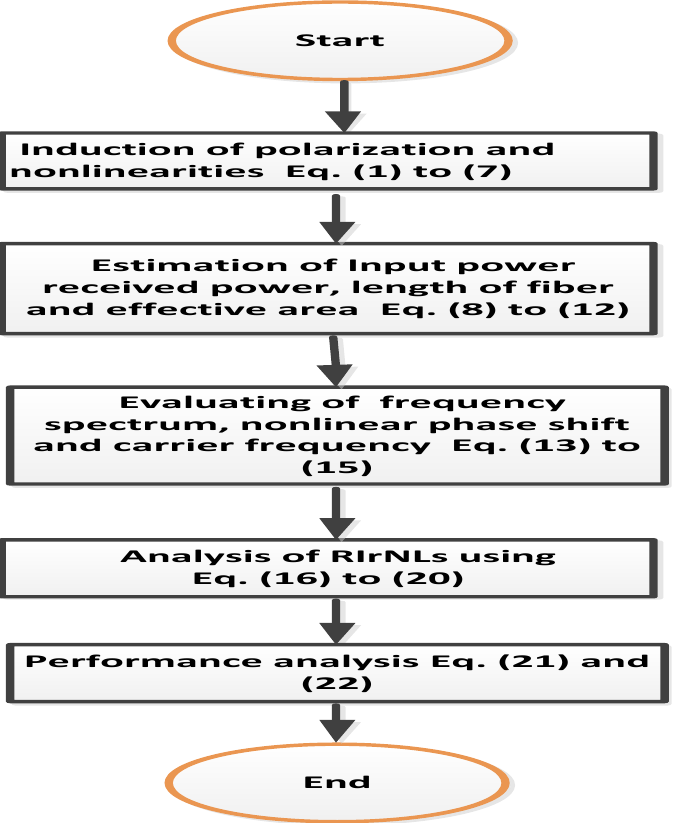
Figure 6. Proposed flow chart to how analytical and simulation models are linked.